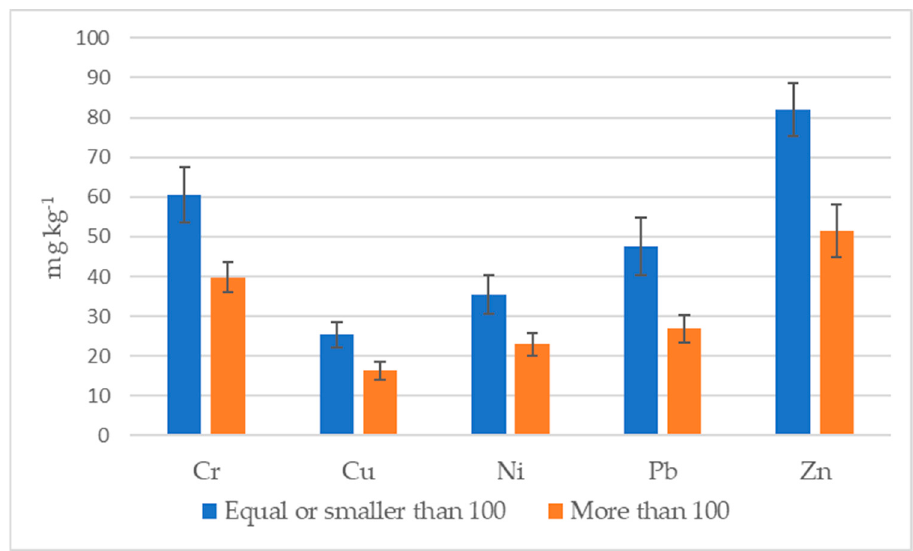
Figure 7. Comparison of mean element concentration against distance − for metals from sides with a downwind direction.